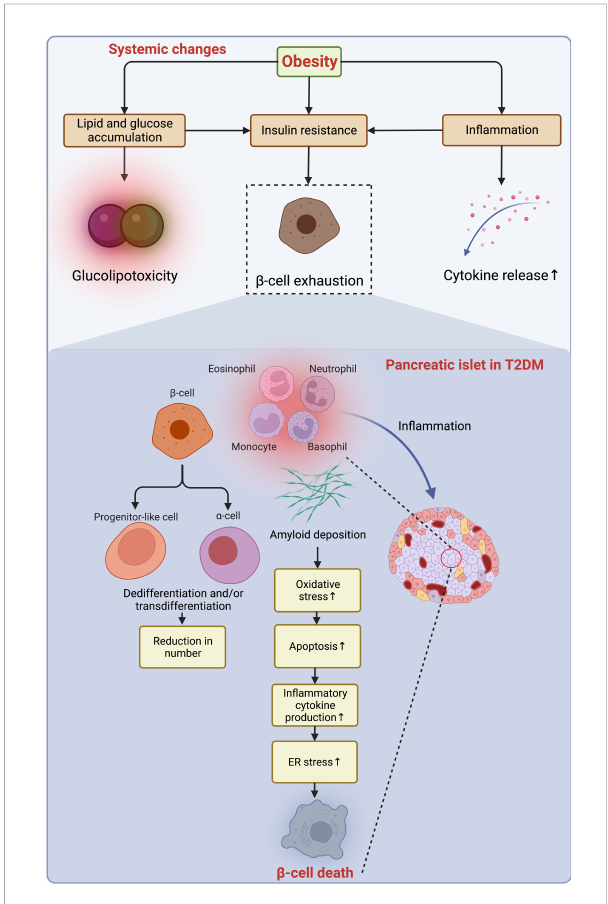
FIGURE 5 Obesity-induced acceleration of b -cell loss in the pancreatic islets of T2DM. The accumulation of lipid and glucose induces glucolipotoxicity, which jointly exacerbates insulin resistance and exhausts b -cells with enhanced low-grade in fl ammation owing to the increased secretion of pro-in fl ammatory cytokines to the microenvironment. In the islets of T2DM with a similarity to the in fl ammatory microenvironment as in adipose tissue, the deposition of amyloid worsens oxidative stress, resulting in increased apoptosis of b -cells, while the dedifferentiation of b -cells to progenitor-like cells or transdifferentiation to other identities (e.g., a -cells) further jeopardize the b -cell population. Collaboratively, the constant pro- apoptotic and pro-in fl ammatory signals promoting ER stress lead to b -cell loss. ER, endoplasmic reticulum; T2DM, type 2 diabetes